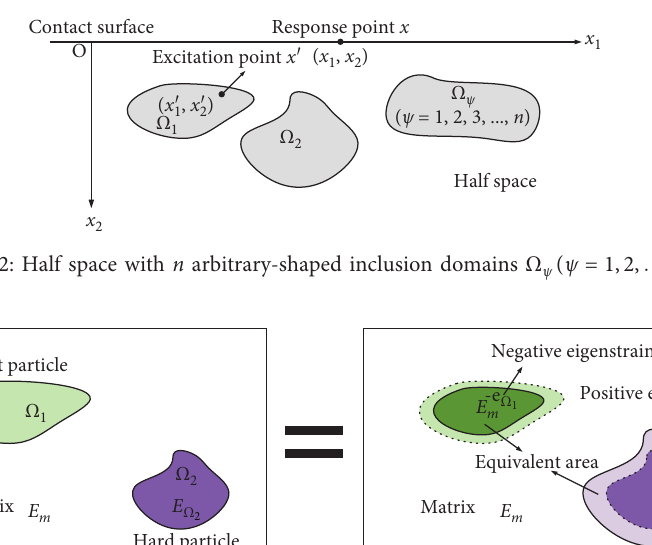
Figure 3: Principle of equivalent inclusion.